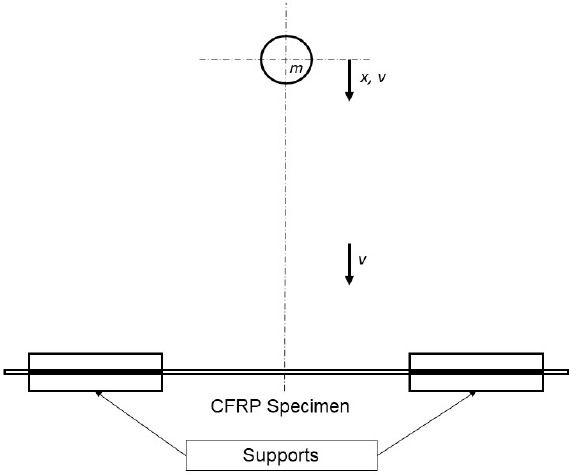
Figure 1. The drop-weight impact test